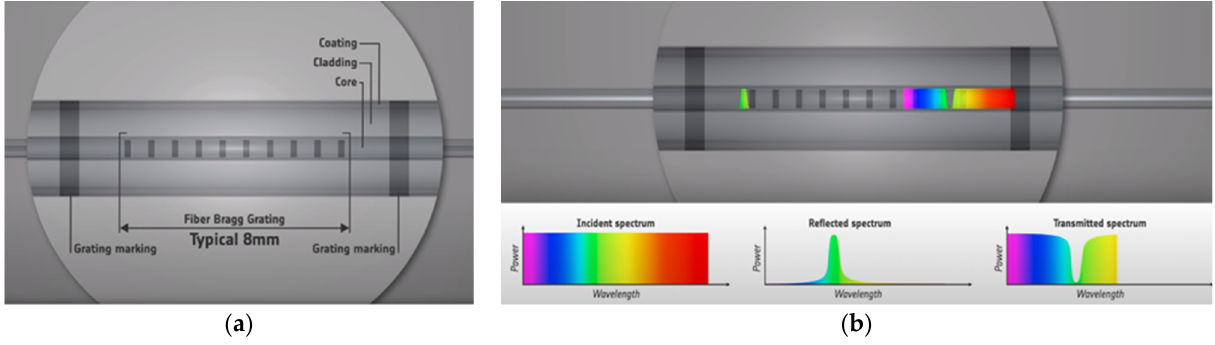
Figure 6. ( a )FBG sensor; ( b ) Working mechanism of FBG Sensor [19].